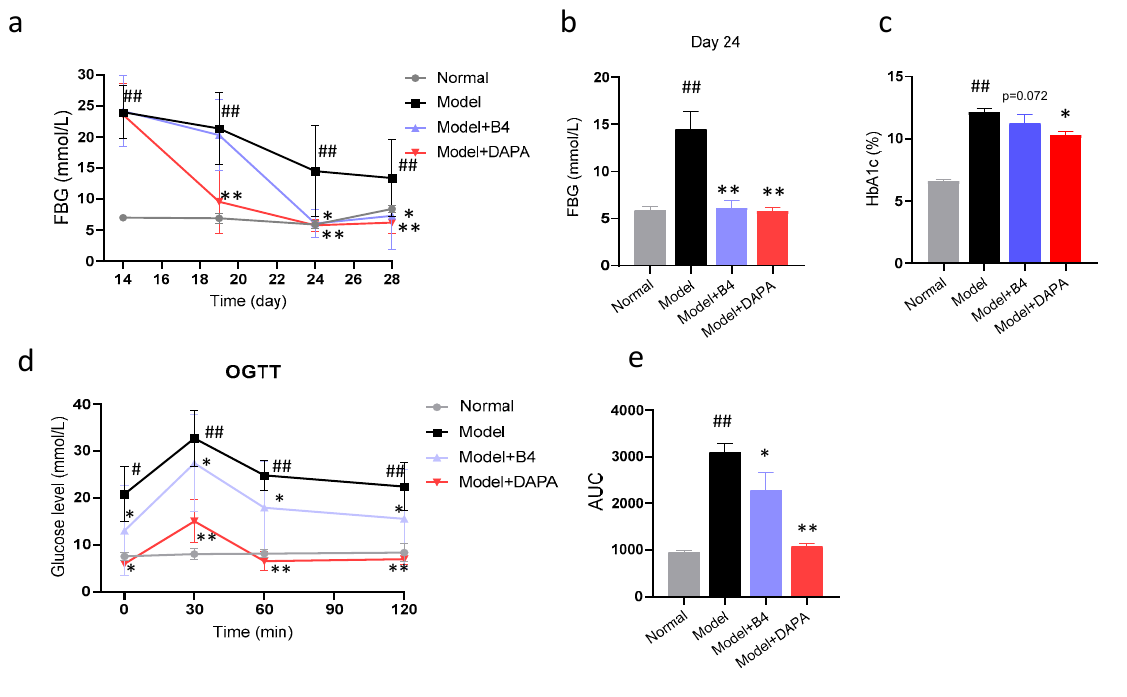
Figure 1. Effect of anemaside B4 (B4) on blood glucose of hyperglycemia rats. ( a ) FBG level on different days after administration; ( b ) FBG level after 10 days administration; ( c ) HbA1c level at the end of administration; ( d ) FBG levels at different times in the oral glucose tolerance test (OGTT); ( e ) The AUC of OGTT. # p < 0.05, ## p < 0.01 vs. Normal group; * p < 0.05, ** p < 0.01 vs. Model group.